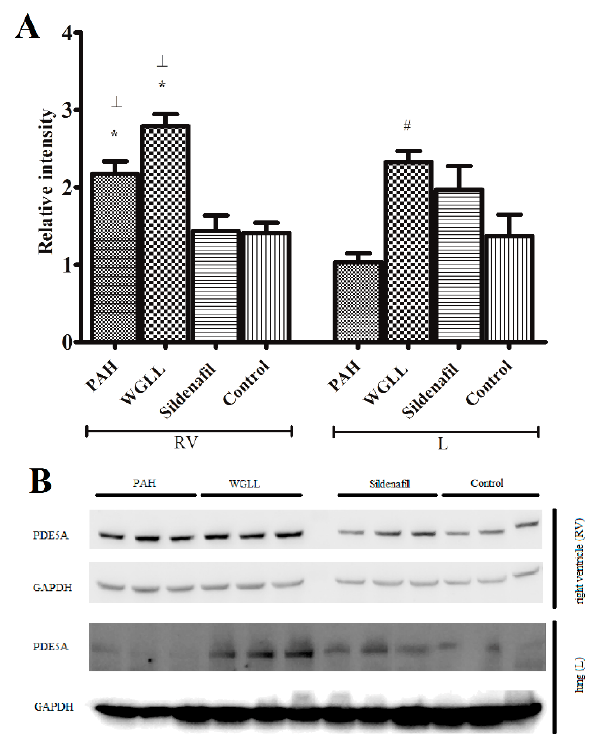
Figure 2. Outcomes of histological analyses of rats receiving four treatments: PAH (pulmonary arterial hypertension), WGLL (Wild garlic ( Allium ursinum ) liophylisate-enriched chow), Sildenafil injections, and Control. Respective figures are: ( A ) Representative images of HE-stained transversal whole heart sections, RV = right ventricle, LV = left ventricle; ( B ) HE staining of the rat hearts from short-axis slice (magnification: 40×); ( C ) Histological examination (HE staining) of lung tissues (magnification: 40×); ( D ) Elastica van Gieson (EVG) staining demonstrates the thickness of pulmonary arterial wall in lung tissues (magnification: 40×); ( E ) Right ventricular hypertrophy (RVH) shown as RV/(LV + S) ratio; and ( F ) Quantitative analysis of peripheral pulmonary arteries demonstrates the medial wall thickness (MWT) in PAH, WGLL, Sildenafil and Control groups. The medial wall thickness was calculated by the equation: % MWT = (M1 + M2)/ED × 100. Dark triangles mark the small pulmonary arteries ( B – D ). Lenght of blue scale bars on ( A ): 5000 µm; lenght of red scale bars on ( B – D ): 500 µm. Values are expressed as mean ± standard error of mean (SEM; n = 15/group). * p < 0.05 compared to Control; ** p < 0.05 compared to WGLL; ┴ p < 0.05 compared to Sildenafil.